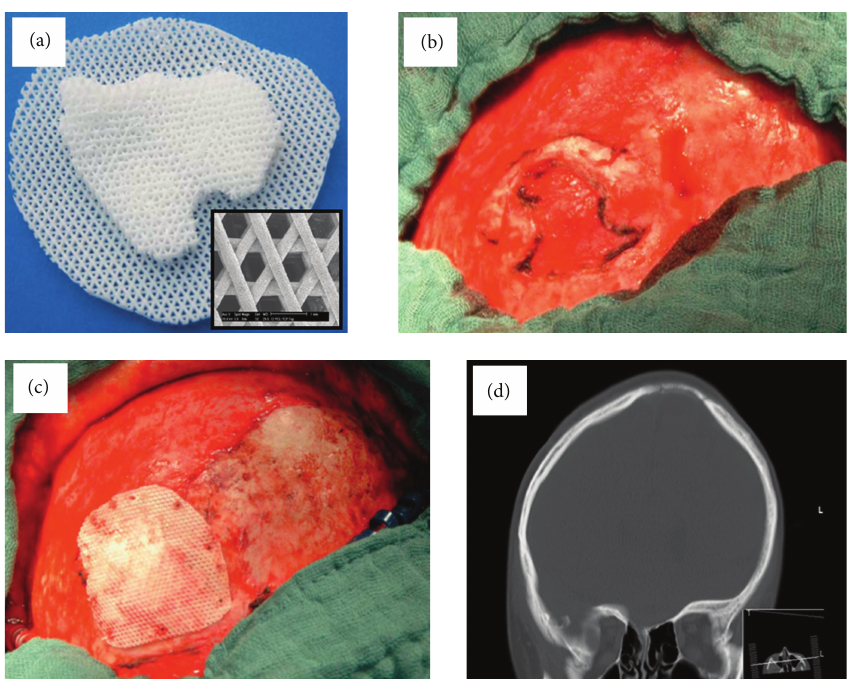
F 4: Clinical application of a cell-free polycaprolactone-calcium phosphate scaffold for bone regeneration in a calvarial defect. Scaffold designed using CT imaging data and fabricated by fused deposition modeling (a). Calvarial defect (b). Defect aer implantation of the scaffold (c). CT images showing bony consolidation of the defect aer 6 months (d). Reproduced with permission from Georg ieme Verlag (2012)